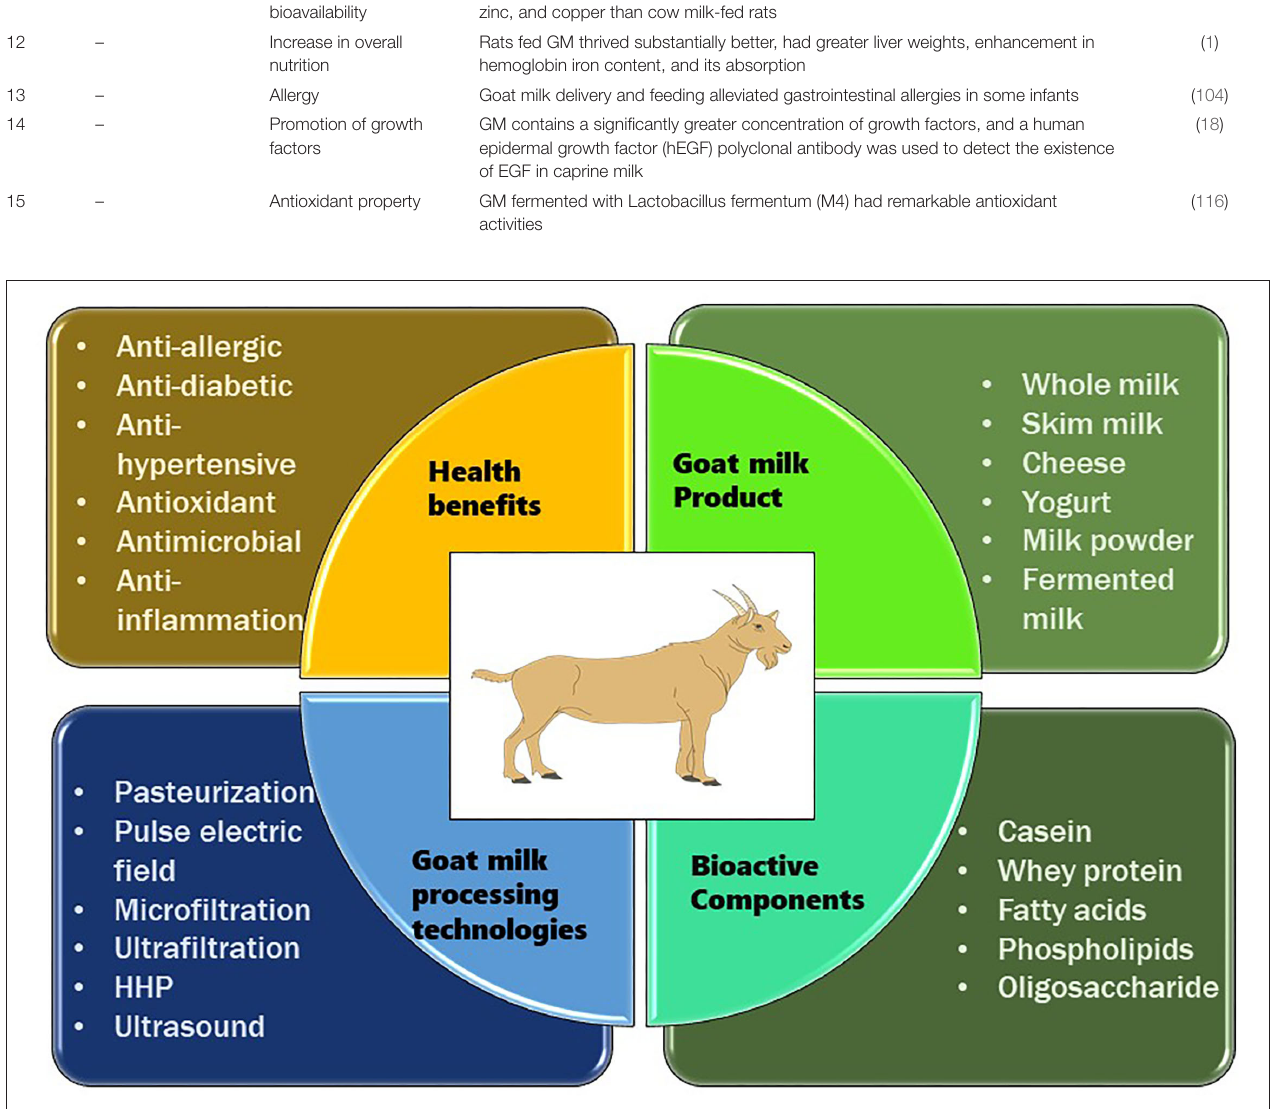
acids, are beneficial for higher digestion and better metabolism of lipid when compared to cow milk (10). In their study (118) found that giving goat milk rather than cow milk in the diet resulted in higher biliary production of cholesterol and a decrease in the content of plasma cholesterol. The bile acid and phospholipid outputs, as well as the lithogenic index, remained within normal limits. Furthermore, consumption of goat milk reduces plasma triglyceride concentrations and thus has a positive effect on the metabolism of lipid identical to that of consumption of diet including virgin olive oil